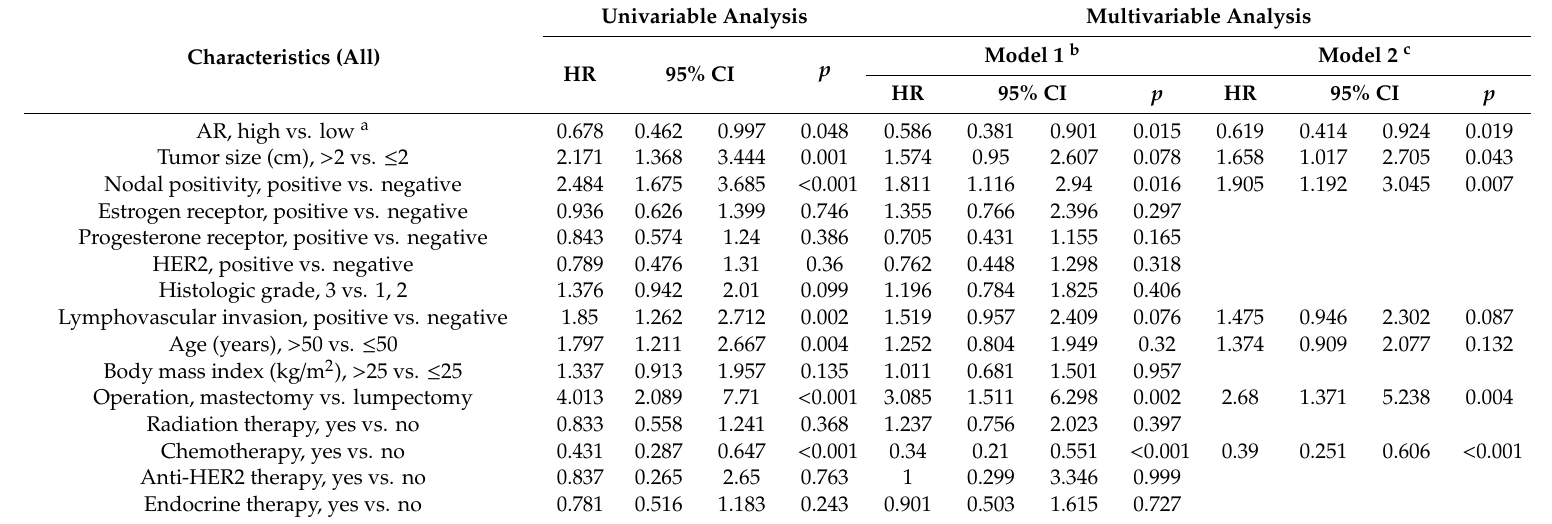
Table 2. Univariable and multivariable analyses regarding overall